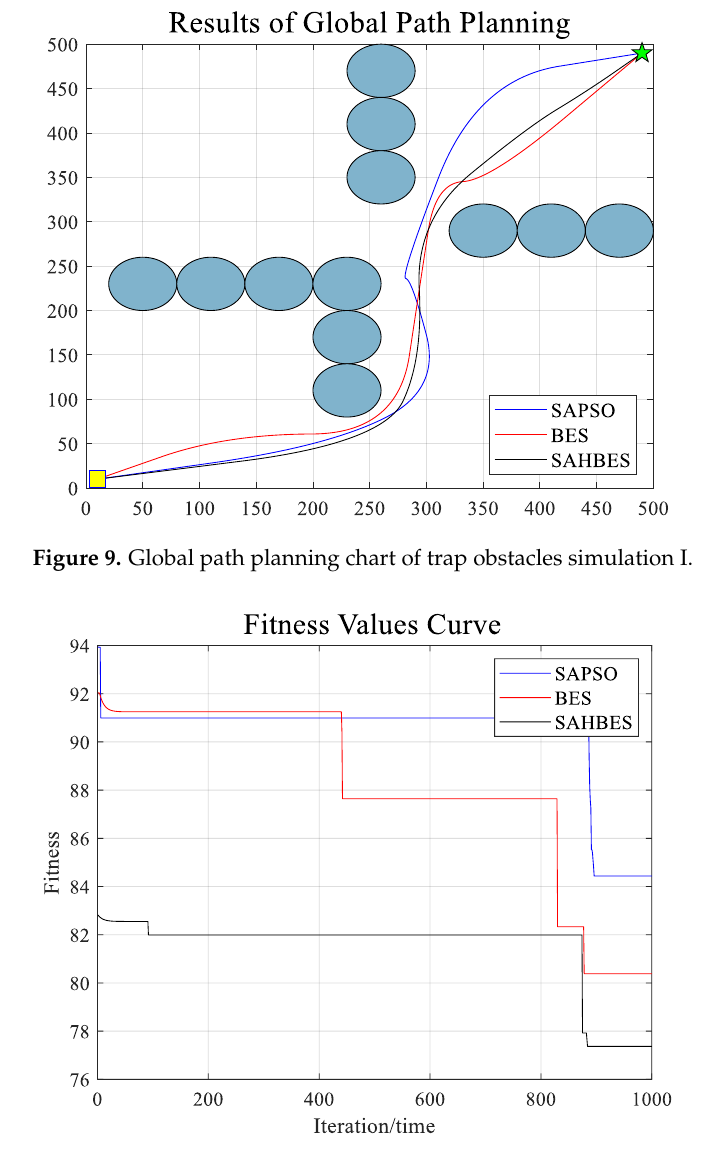
Figure 10. Comparison of three algorithms’ fitness values of simulation I.